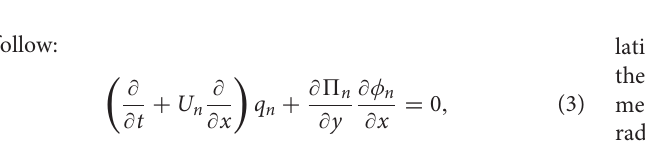
where q n is the perturbation potential vorticity, φ n is the perturbation stream function, and (cid:53) n is the mean potential vorticity in the n -th layer ( n = 1 and